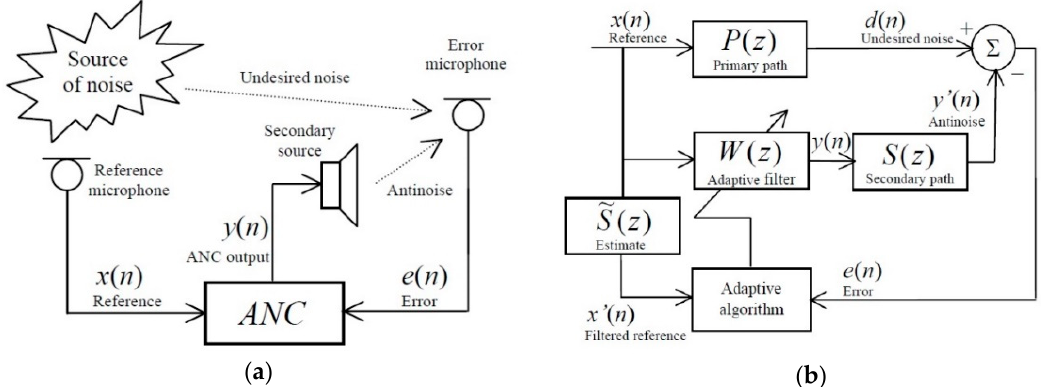
Figure 1. Single-channel active noise control system using the FxLMS algorithm. ( a ) Physical arrangement of the electro- acoustic elements. ( b ) Equivalent block diagram.